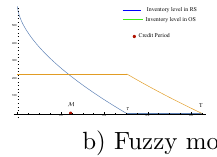
Figure 2. Inventory model in Example 1.